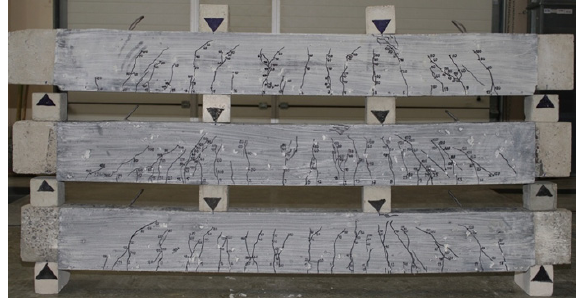
Fig. 12. Marked cracks on the S4T, S5T, and S6T beams (from the top)